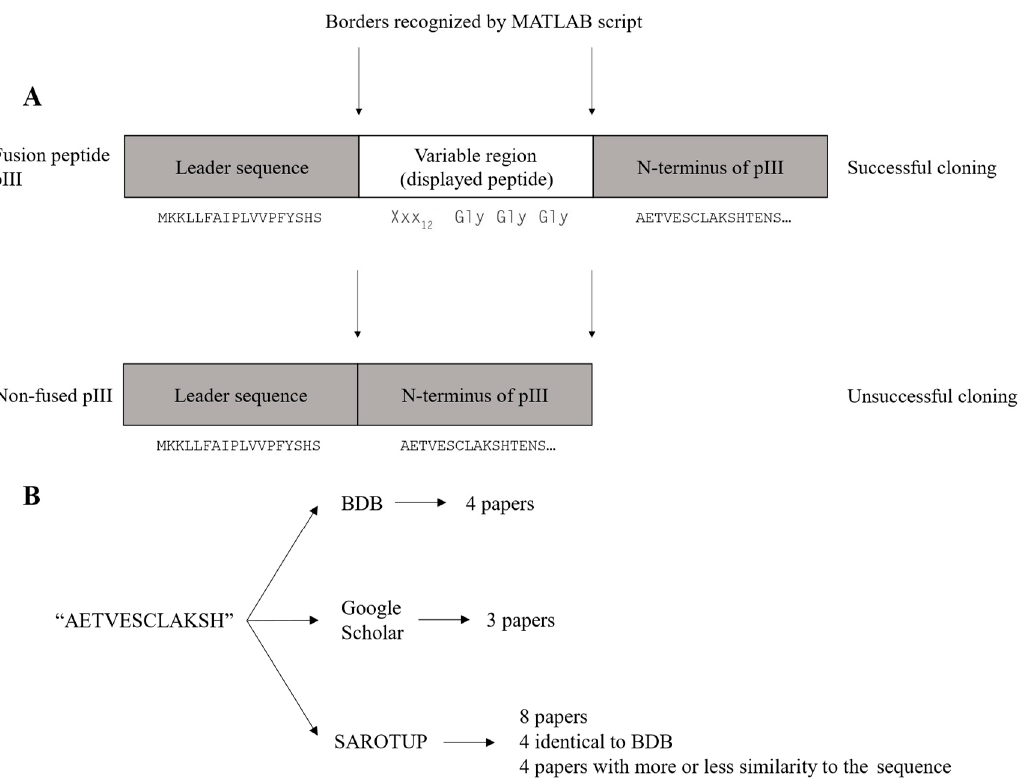
Figure 2. ( A ) An overview of the fusion peptide pIII in the case of successful and unsuccessful cloning of the variable region into the M13KE vector. MATLAB script recognizes a fragment corresponding to the borders of the variable region, displaying the peptide. In the case of unsuccessful cloning of the variable region, the area recognized by the script will correspond to the N-terminus of pIII, resulting in reads with the sequence: AETVESCLAKSHTENS. ( B ) Flow chart of literature search for the ‘AETVESCLAKSH’ sequence.